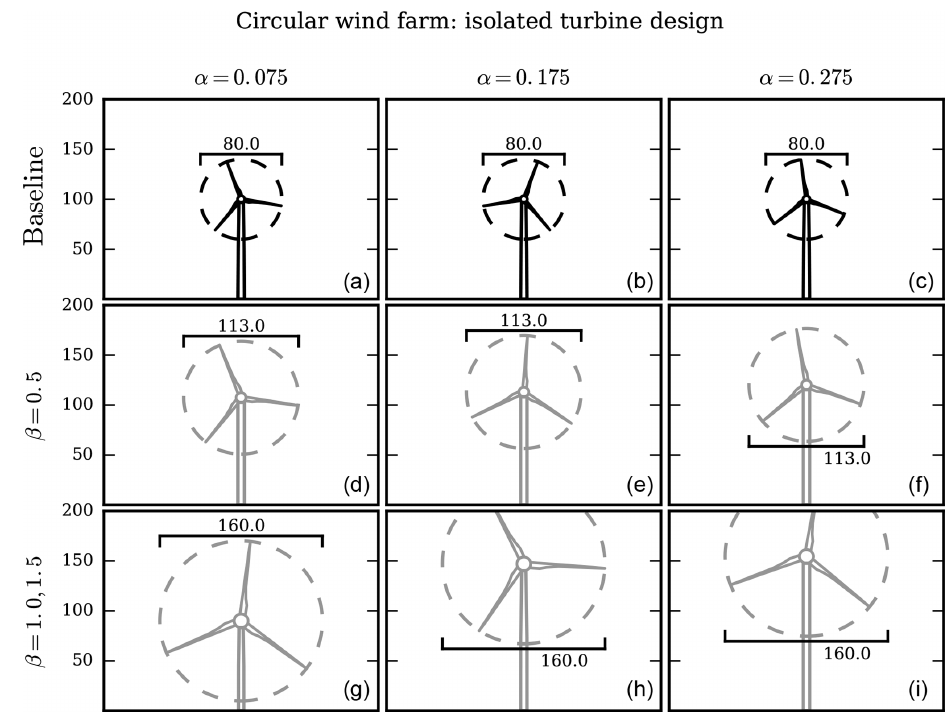
Figure 10. The optimal turbine heights and rotor diameters for the isolated turbine design optimization for the circular farm wind conditions. These designs were then used in the sequential optimizations of turbine design, then layout. The columns, from left to right, show the turbines optimized for α = 0 . 075, 0 . 175, and 0 . 275. The rows, from top to bottom, show the baseline turbine design, the turbine optimized for the small wind farm ( β = 0 . 5), and the turbine designs for the larger wind farms ( β = 1 . 0, 1 .